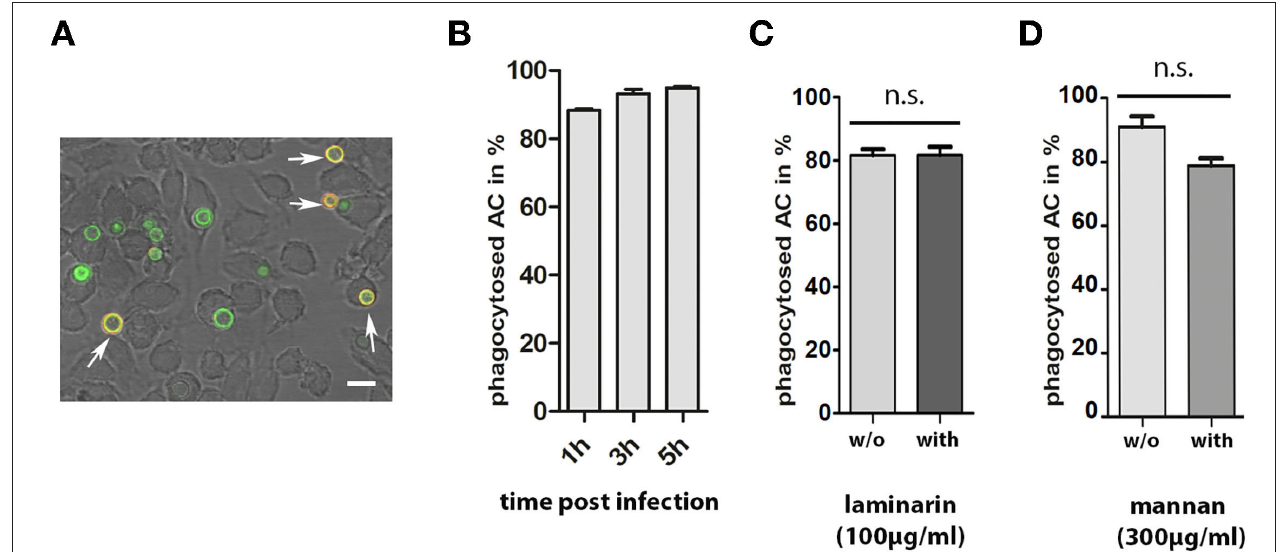
FIGURE 7 | Phagocytosis of AC by J774 macrophages. J774 cells were infected with one FITC-labeled AC per two J774 cells. After 1, 3, and 5h of co-incubation, samples were fixed and extracellular AC were stained with mab L10-1. A representative image is shown in (A) . Extracellular conidia are indicated by arrows. The bar represents 10 µ m. (B) shows the percentage of internalized AC at three different time points. Each column represents the values of four groups with 100 events each. Parallel experiments were performed in the presence of laminarin (100 µ g/ml) and mannan (300 µ g/ml) ( C , D , respectively). In these experiments, cells were fixed after 1h. Each column represents the values of three groups with 100 events